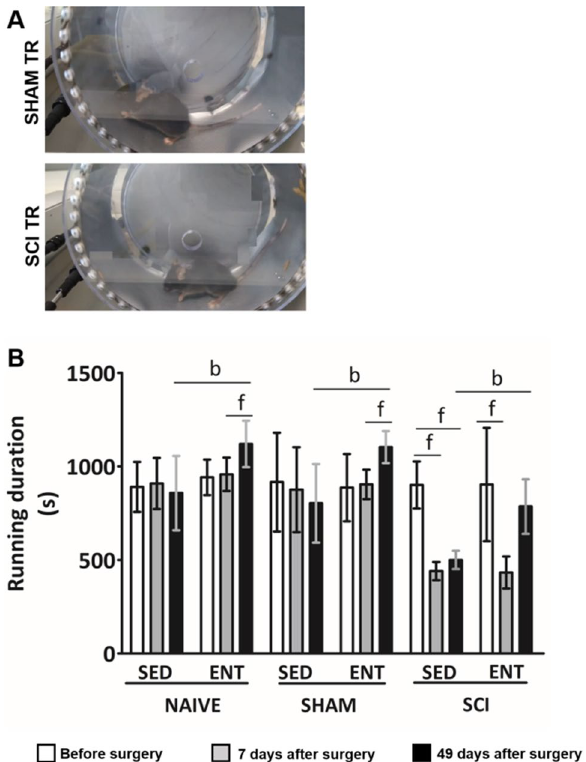
Figure 2. Maximal physical capacity expressed as running time (s). ( A ) Representative snapshot of a SHAM (upper) and SCI (below) mouse running in forced exercise wheel. ( B ) Running capacity on forced exercise wheel at different time points (before SCI; 7 days after surgery and 49 days after surgery). Data are presented as mean ± SD (n = 6). Significance: b p < 0.05 compared to sedentary, f p < 0.05 compared to before surgery or 7 days after